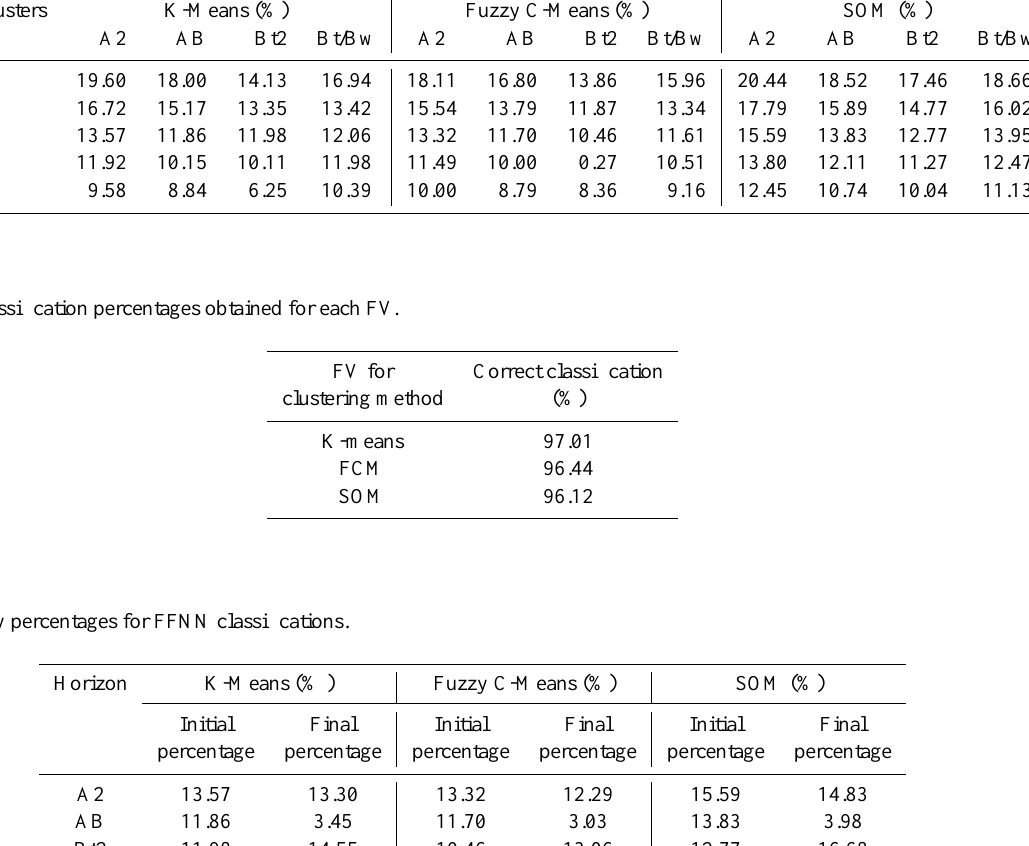
Table 3. The percentage of pore space obtained in clustering methods for each horizon, where the cluster number takes values ranging from 7 to 11. No. of Clusters